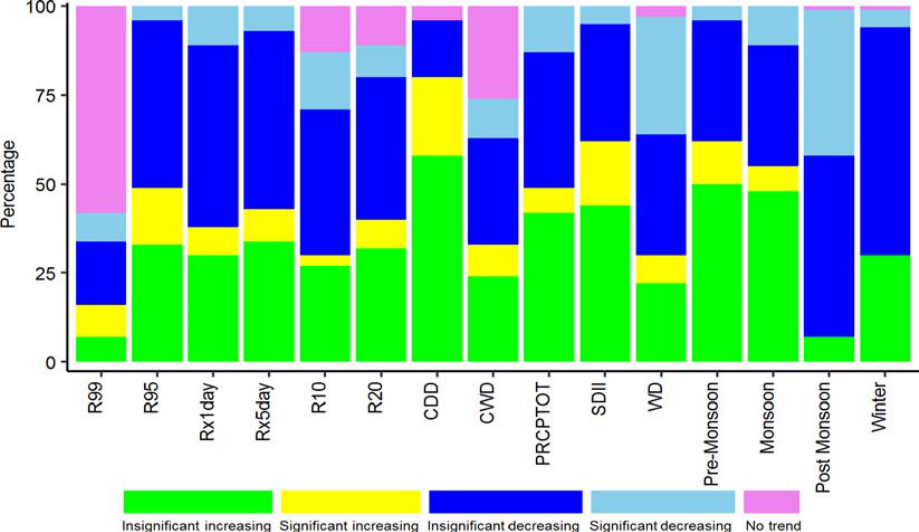
Figure 6. Percentage (from total stations) of stations with different trend features in Nepal.